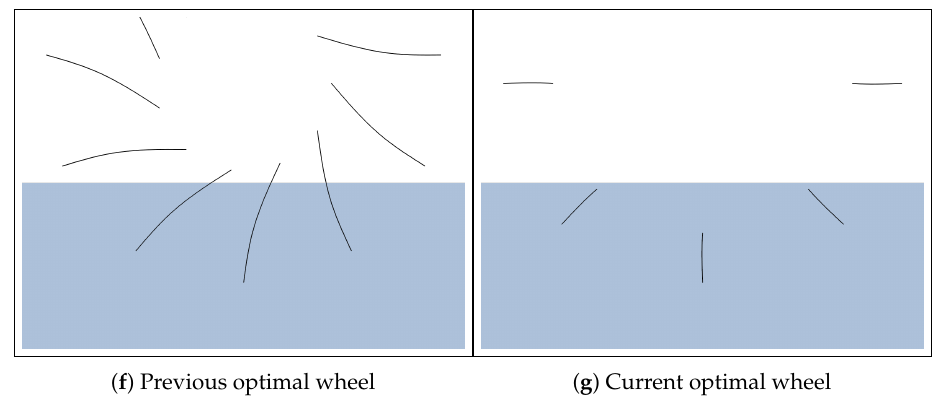
Figure 12. Sketch of the geometry of the optimal wheel obtained from the previous optimisation study (top) and the optimal wheel from the current study (bottom), for the same radius and depth. The performance of each wheel was evaluated, with each operated at its respective optimum tip-speed ratio. The results of this comparison are presented in Table 5. Table 5. On the left, one design among a family of optimal designs obtained in the previous op- timisation study [17], selected because its radius matches that of the current study. On the right, the optimum designed obtained in the current optimisation study. The performance of both wheels is evaluated at their optimum tip-speed ratio. Wheel Selected Out of Previous Current Optimal Wheel, Design Optimisation